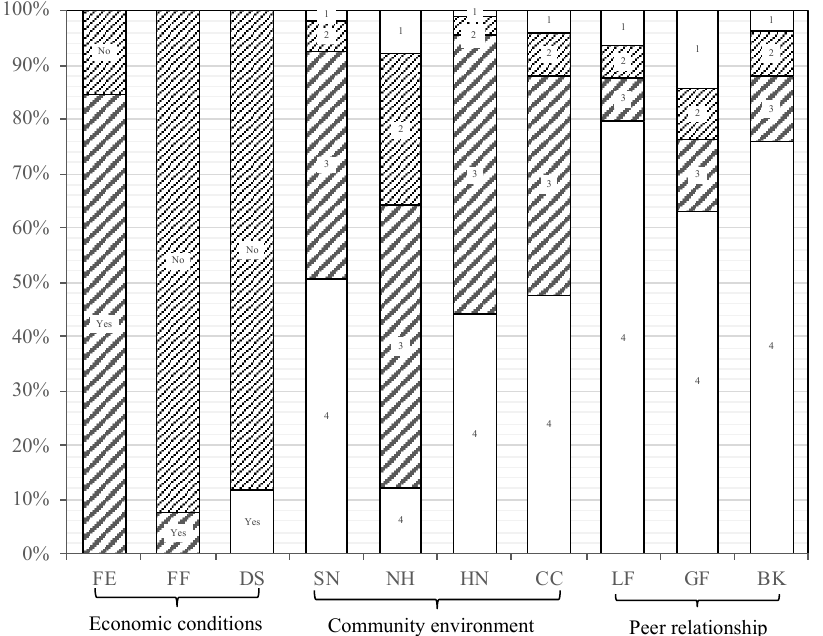
Figure 2. Column chart of ten indicator variables.